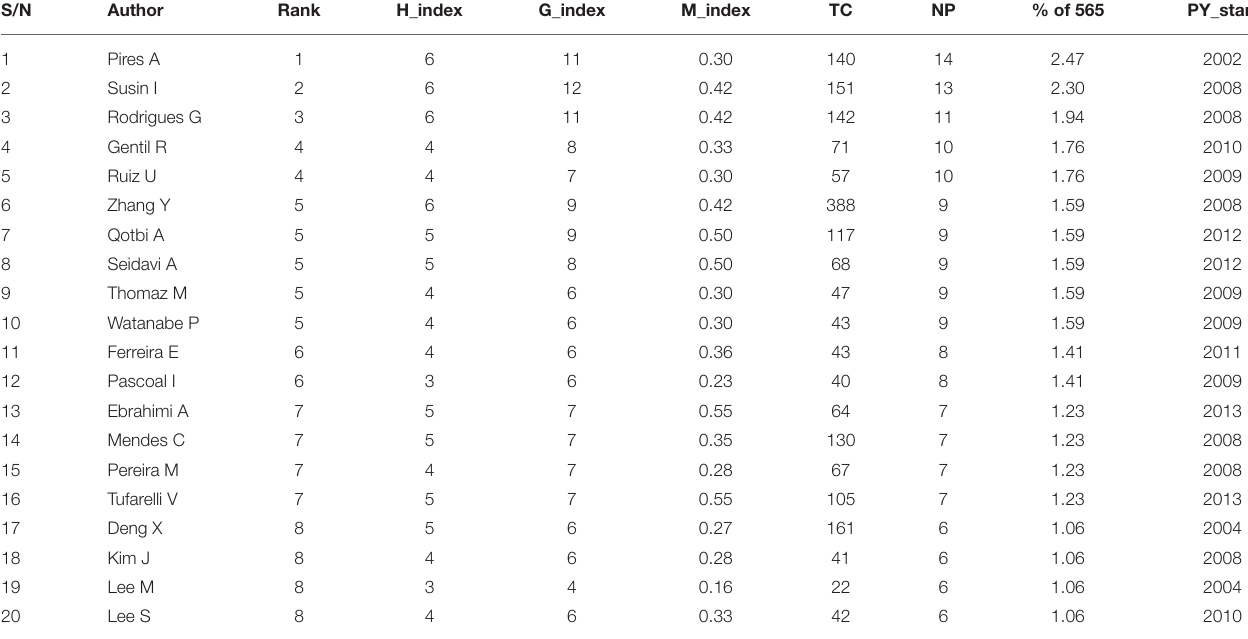
TABLE 5 | Top 20 relevant/productive authors on citrus waste and animal feed for livestock